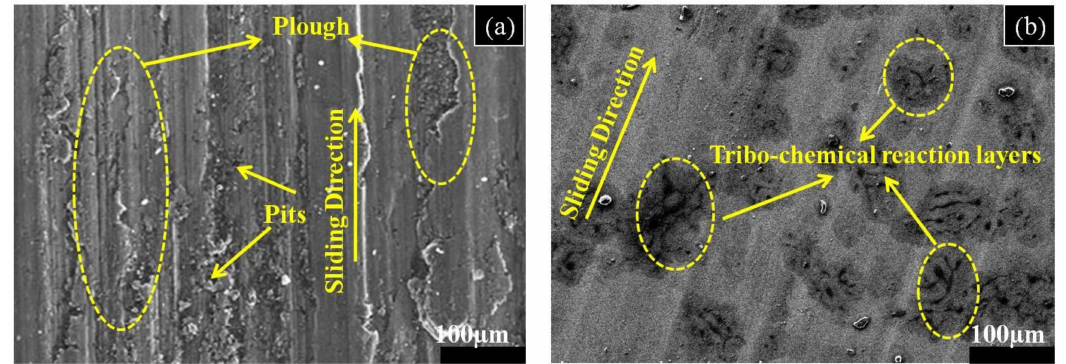
Figure 7. FE-SEM images represent the wear appearances of ( a ) Untreated substrate; ( b ) EDMed